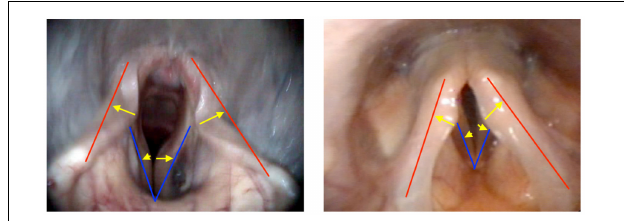
FIGURE 4 | Endoscopic photographic images during exercise of: (left) moderate dynamic laryngeal collapse in an equine. (Right) Grade 3 combined supraglottic and glottic EILO in a human. Red lines denote expected line of aryepiglottic fold in a normal subject. Blue lines denote expected line of vocal fold in normal subject. Yellow arrows denote degree of collapse to normal.